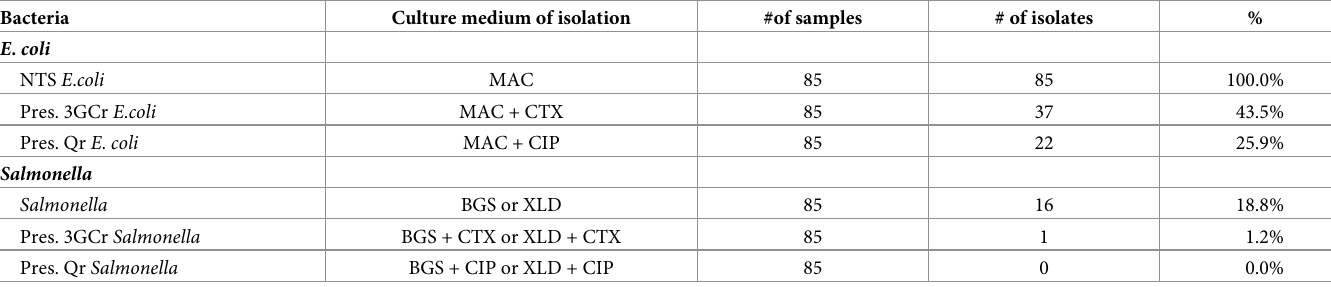
Table 1. Numbers of bacteria isolated from dairy cattle feces at a dairy farm in Texas. Bacteria